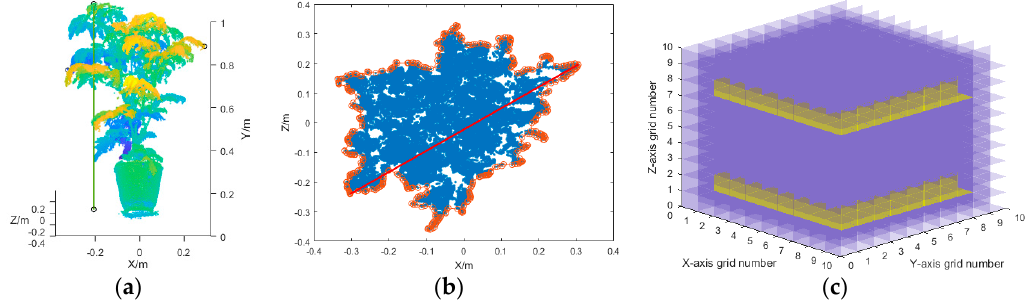
Figure 8. Calculation of canopy morphology parameters of a greenhouse tomato plant: ( a ) Total plant height; ( b ) Convex boundary point set of the canopy projection, and canopy maximum width; ( c ) Voxel division of the cuboid (10 × 10 × 10).